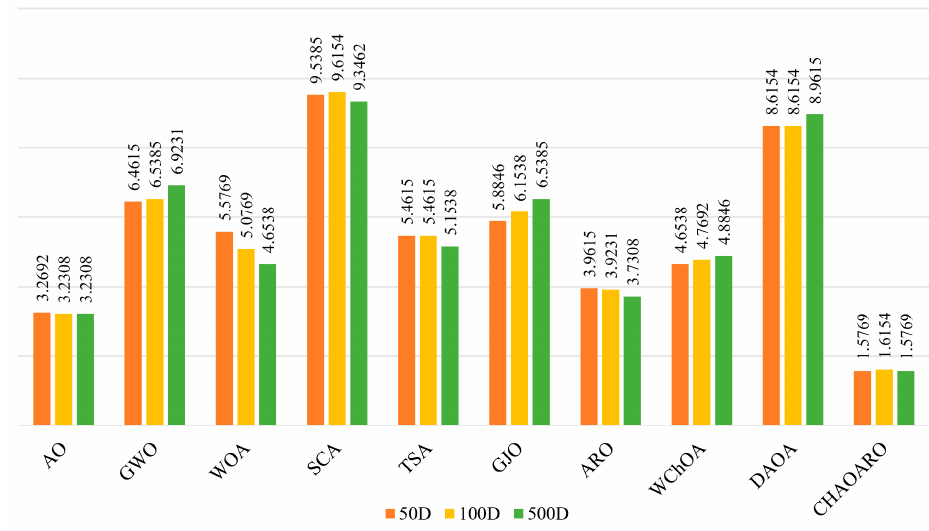
Figure 9. Friedman mean ranking of CHAOARO and its peers in different dimensions. Table 7. Statistical results of Wilcoxon rank-sum test for different algorithms on 23 benchmark func- tions.